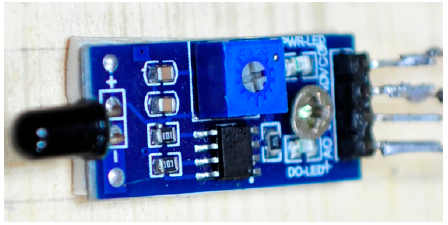
Figure 3. Flame detector.